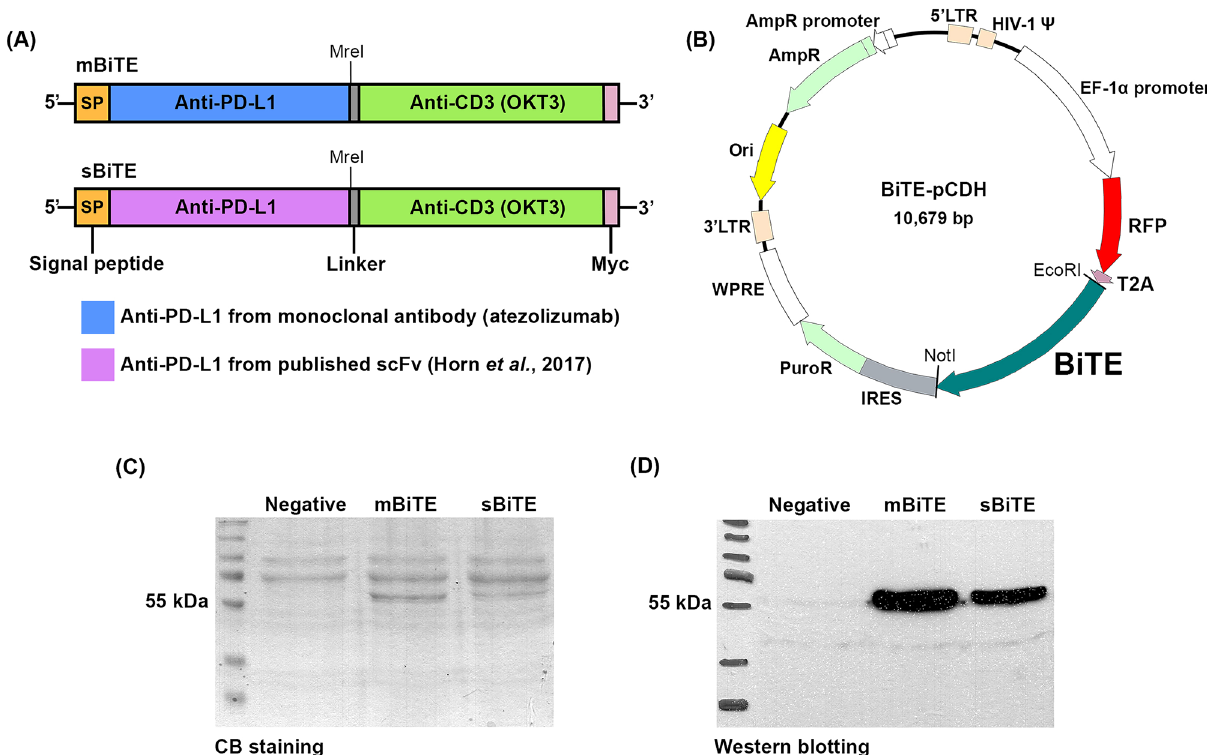
Figure 2. PD-L1xCD3 BiTE constructs and expression in HEK293T. ( A ) PD-L1xCD3 BiTE gene arrangement of mBiTE and sBiTE ( B ) Construct map of PD-L1xCD3 BiTE in pCDH plasmid backbone; RFP (red fluorescent protein), T2A (self-cleaving peptide), IRES (internal ribosome entry site), and PuroR (Puromycin resistant gene). PD-L1xCD3 BiTE protein produced from HEK293T was detected by Coomassie Brilliant Blue staining ( C ) and Western blot analysis ( D ).